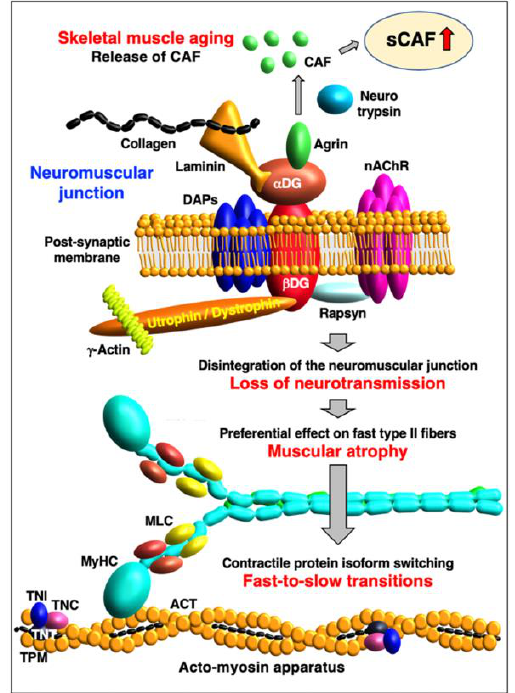
Figure 5. Agrin as a potential serum biomarker of skeletal muscle aging. Shown is the linkage between the disintegration of the neuromuscular junction during skeletal muscle aging and resulting preferential loss of neurotransmission to fast type II fibers. A potential biomarker candidate of this process is the release of carboxy-terminal agrin fragments (CAF) that can be measured in the serum (sCAF) of patients suffering from sarcopenia of old age. At the neuromuscular junction, the proteoglycan agrin associates with the dystroglycan complex (alpha/beta-DG), which forms an integral part of the sub-sarcolemmal utrophin/dystrophin lattice and its associated proteins (DAPs) at the post-synaptic membrane. During skeletal muscle aging, the integrity of the neuromuscular junction is lost, and agrin is proteolytically cleaved by the enzyme neuro-trypsin. This results in the production of distinct agrin fragments that can be conveniently detected in a minimally invasive way in suitable biofluids.